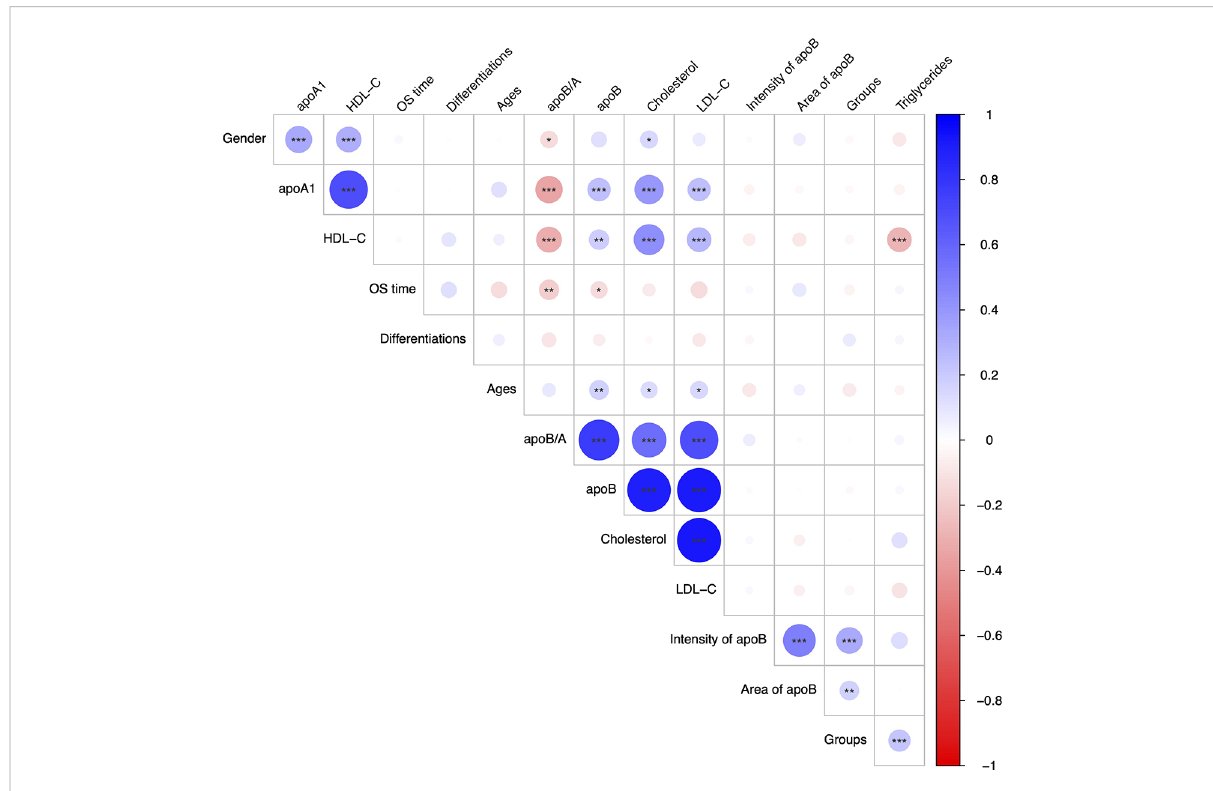
FIGURE 2 Correlation analysis for the interested clinicopathological